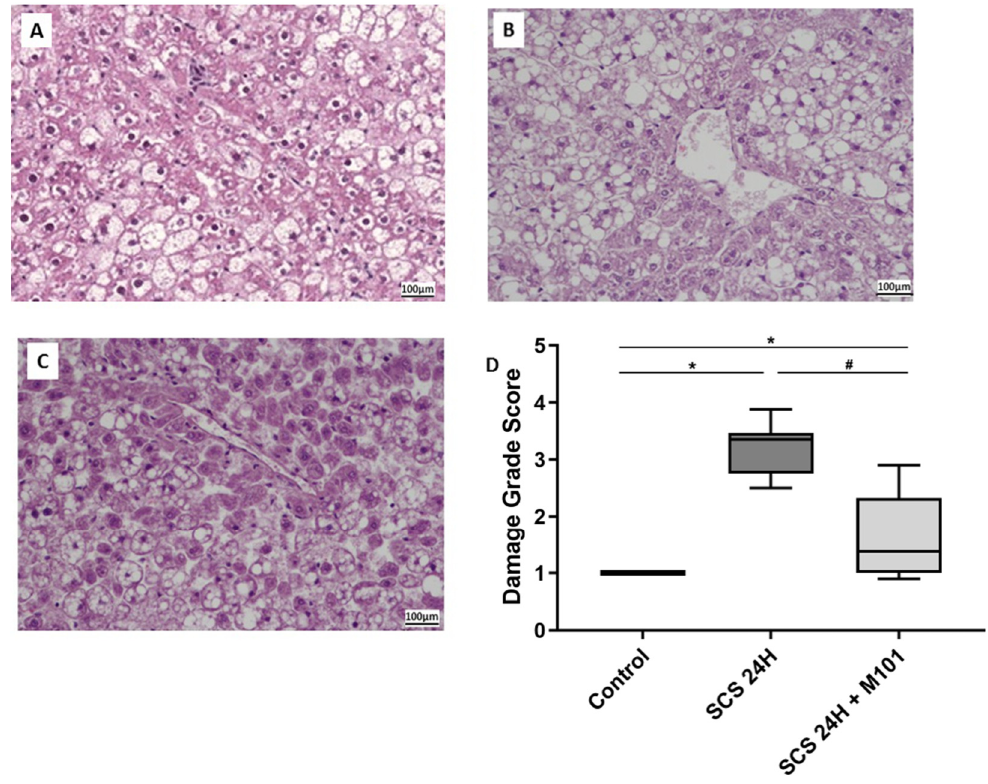
Figure 2. Histological damages reduction with M101. Histology of ( A ) control group; ( B ) SCS-24H group; ( C ) SCS-24H + M101 group. The damage grade score ( D ) is based on necrosis and coagulation, acute necrosis, disorganization, granular precipitate, sinusoidal dilatation, eosinophilic deposits, number of cells remaining in vessels and inflammation, observed by an expert pathologist. Data are represented as mean (SD). n = 12/group, * = p < 0.05 vs. control and # = p < 0.05 vs. SCS- 24H (nonparametric one-way ANOVA (Kruskal–Wallis test)).